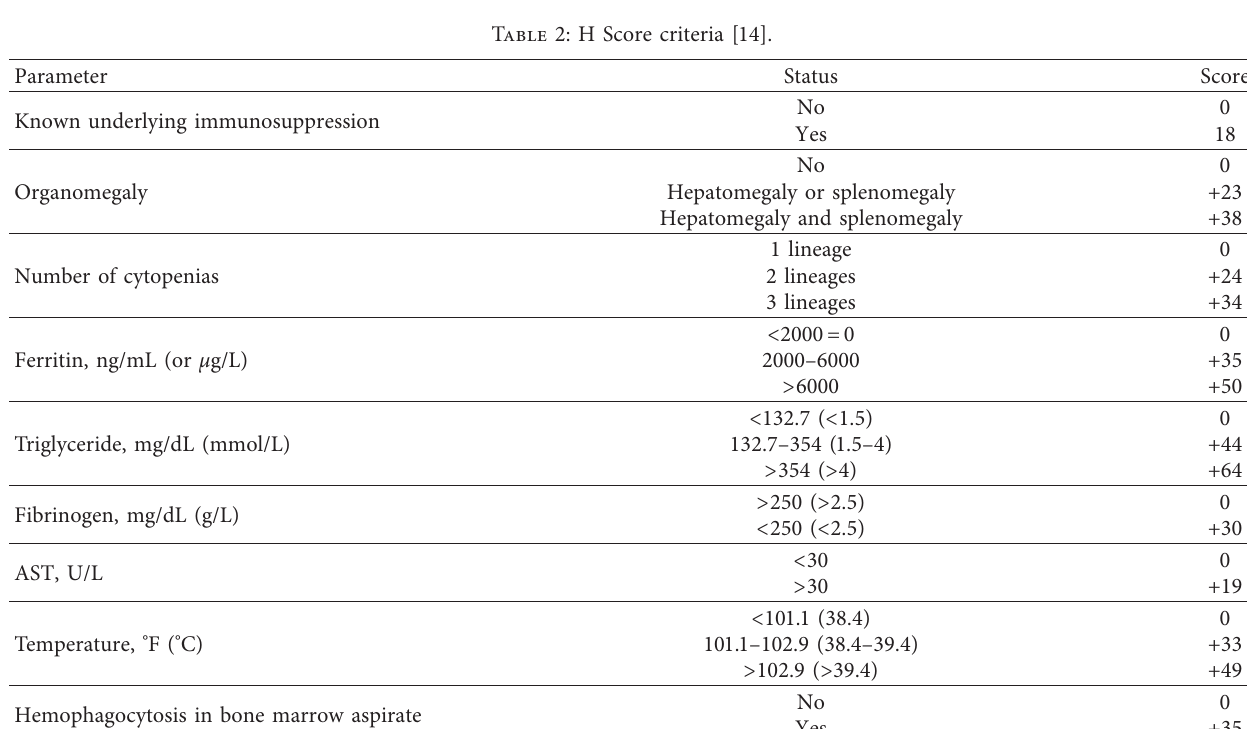
Table 2: H Score criteria